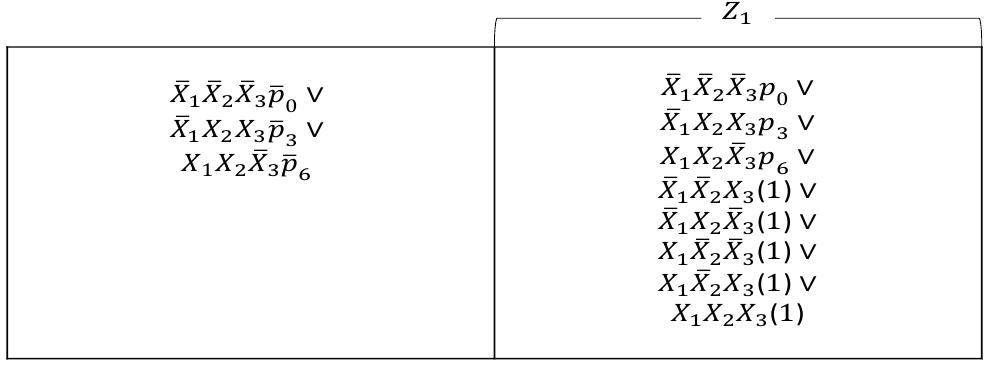
Fig. 16. The auxiliary function for Example